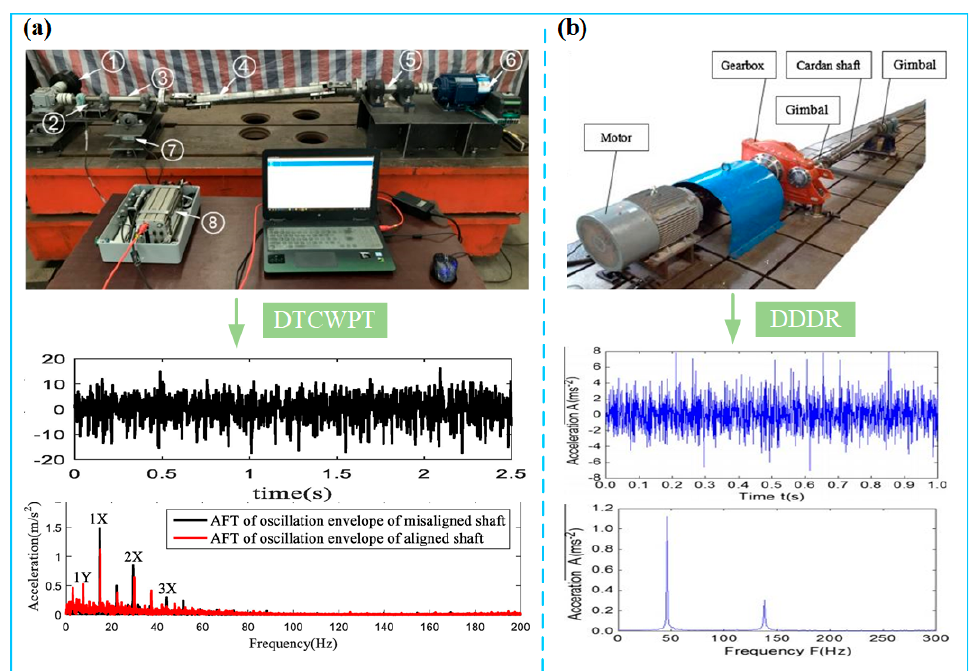
Figure 4. Fault diagnosis method of cardan shaft: ( a ) dual-tree complex wavelet packet transformation (DTCWPT) [41]; ( b ) double decomposition and double reconstruction (DDDR) [42].